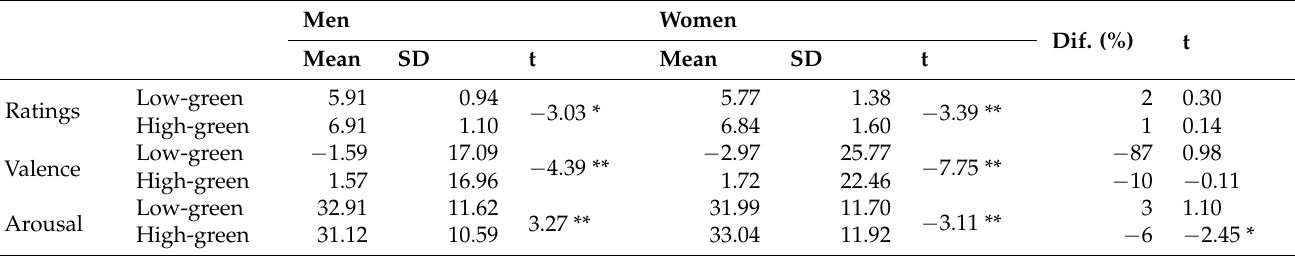
Table 7. Gender differences for perceptions of different amounts of